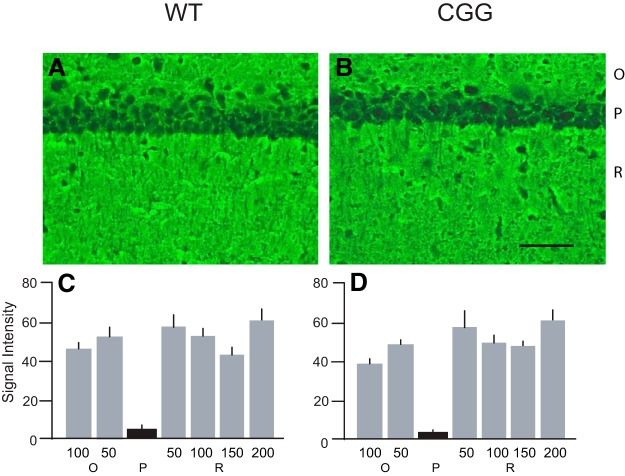
Somato-dendritic distribution of synaptophysin in WT and CGG brains. A, B, Synaptophysin distribution in hippocampal CA1 of WT and CGG animals. CA1 strata oriens (O), pyramidale (P), radiatum (R) are indicated. Scale bars, 100 μm. C, D, Quantitative analysis: one-way ANOVA, p = 0.92571. Comparison of signal intensities (given in relative units) in stratum P (center), in stratum O at distances of 50 and 100 μm from edge of stratum P, and in stratum R at distances of 50, 100, 150, and 200 μm from edge of stratum P, between WT and CGG animals: p > 0.05 for all sample points. n = 4 for WT and CGG.